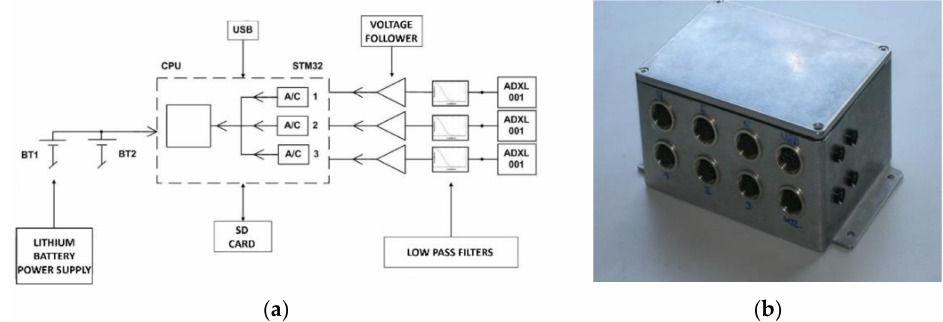
Figure 1. ( a ) ARMS architecture and ( b ) physical